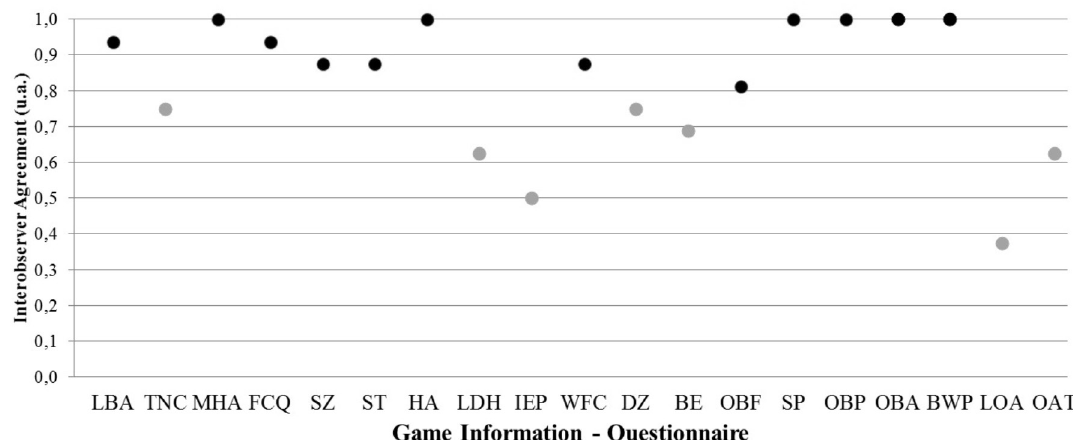
Figure 3: Interobserver Agreement values of each of the game information encountered by the setters during the Counter Attack Processes contained in the